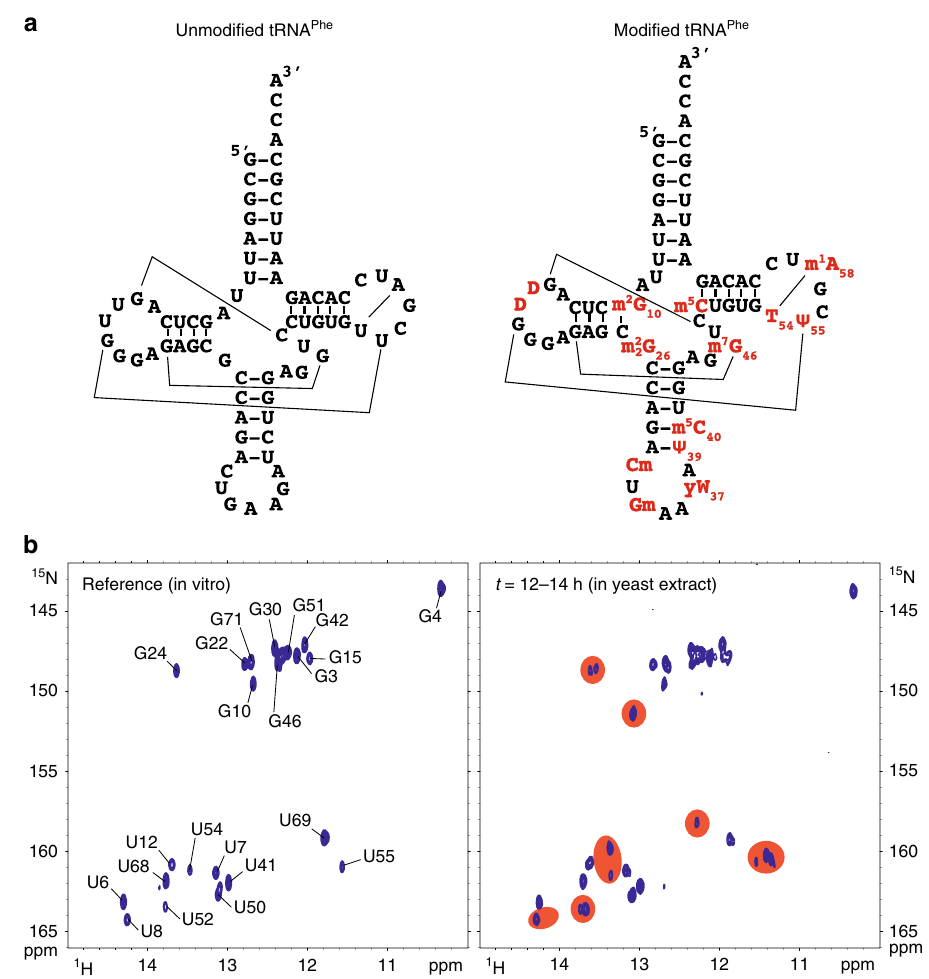
Fig. 2 Modi fi cation of yeast tRNA Phe in yeast extract. a Sequence and cloverleaf representation of unmodi fi ed yeast tRNA Phe (left) and modi fi ed tRNA Phe (right). Main tertiary interactions are represented with thin lines. Modi fi cations are in red. b (left) Imino ( 1 H, 15 N) correlation spectrum of a 15 N-labeled unmodi fi ed tRNA Phe measured in vitro in a buffer approaching physiological conditions (see “ Methods ” section). Assignments of the imino groups are reported on the spectrum. (right) Imino ( 1 H, 15 N) correlation spectrum of a 15 N-labeled tRNA Phe measured after 12 h of incubation at 30 °C in yeast extract. The most obvious changes as compared with the spectrum of the unmodi fi ed tRNA Phe are highlighted with red